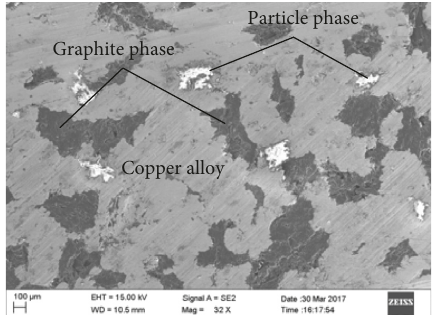
Figure 4: Surface microstructure of the brake